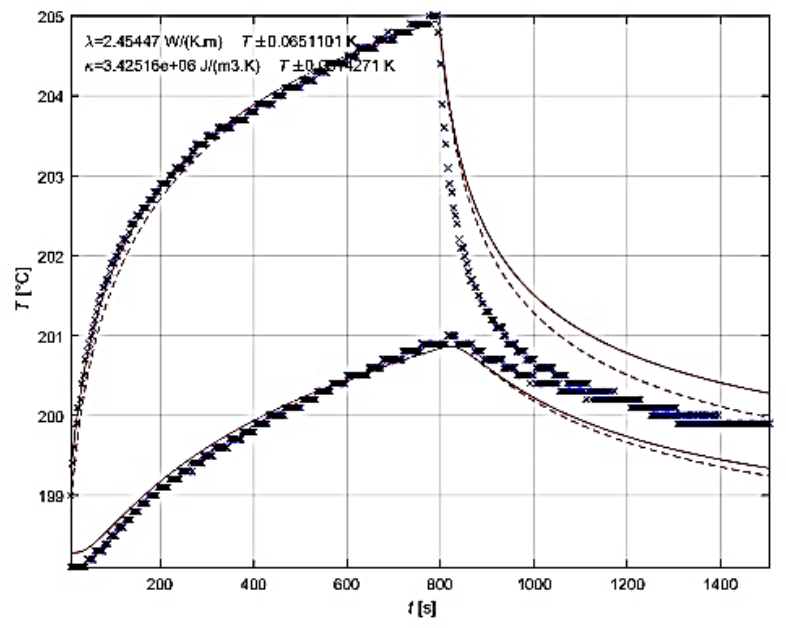
Figure 2. Temperature changes T [°C] in the sample of cementitious composite CC1 at 200 °C depending on time t [s].